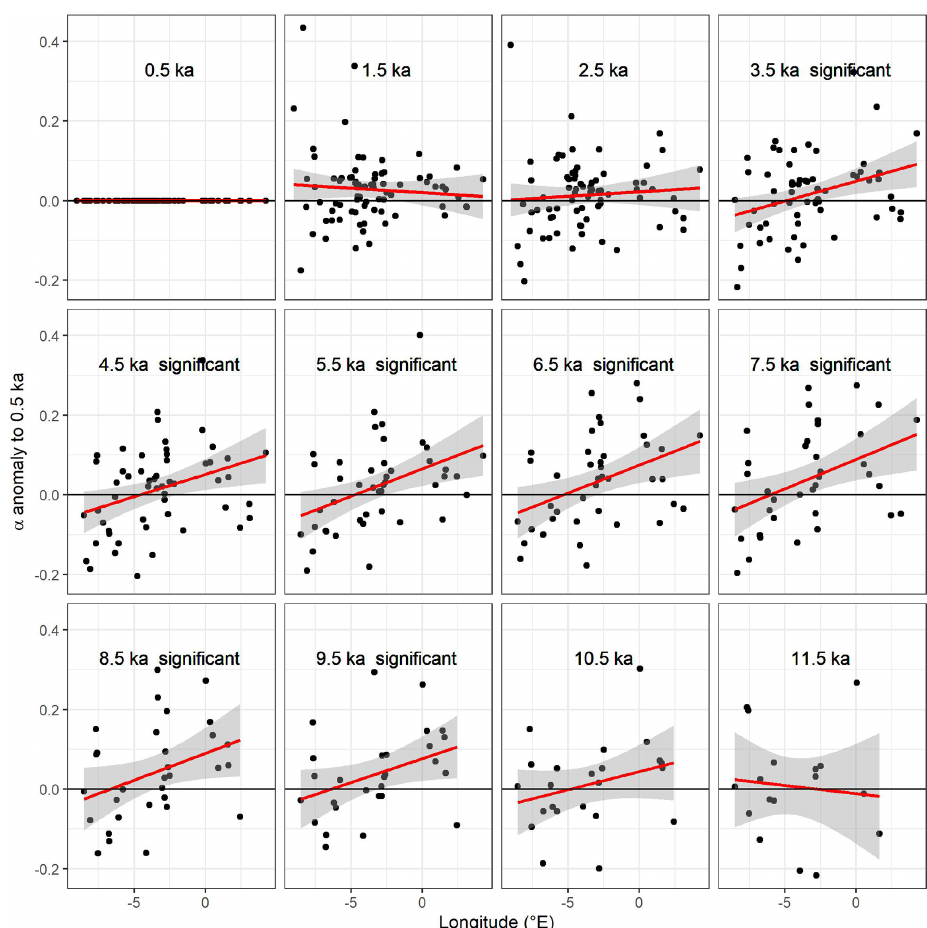
Figure 5. Changes in the west–east gradient of plant-available moisture as represented by anomalies in α relative to 0.5ka at individual sites through the Holocene. The red lines show the regression lines. The shades indicate the 95% confidence intervals of the regression lines